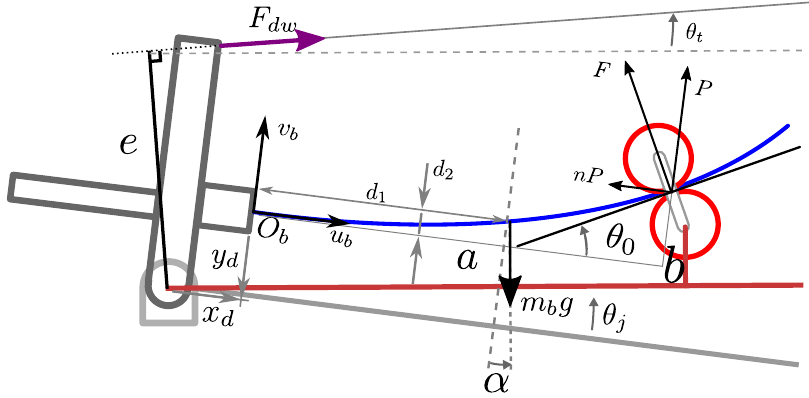
Figure 6. Geometry and loading diagram of the test rig used to derive contact force between roller and